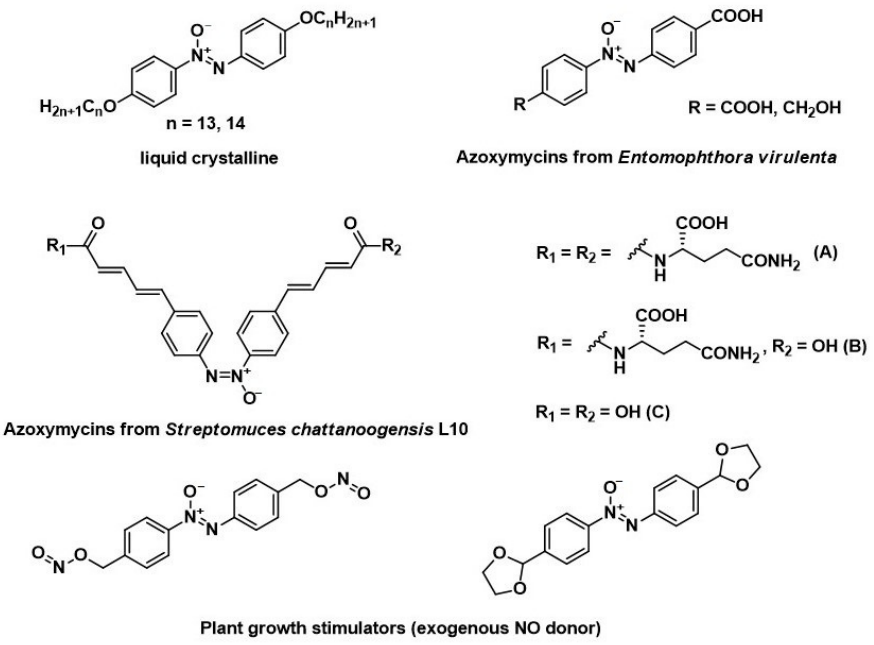
Figure 1. Examples of liquid crystalline and bioactive natural and synthetic azoxybenzenes.